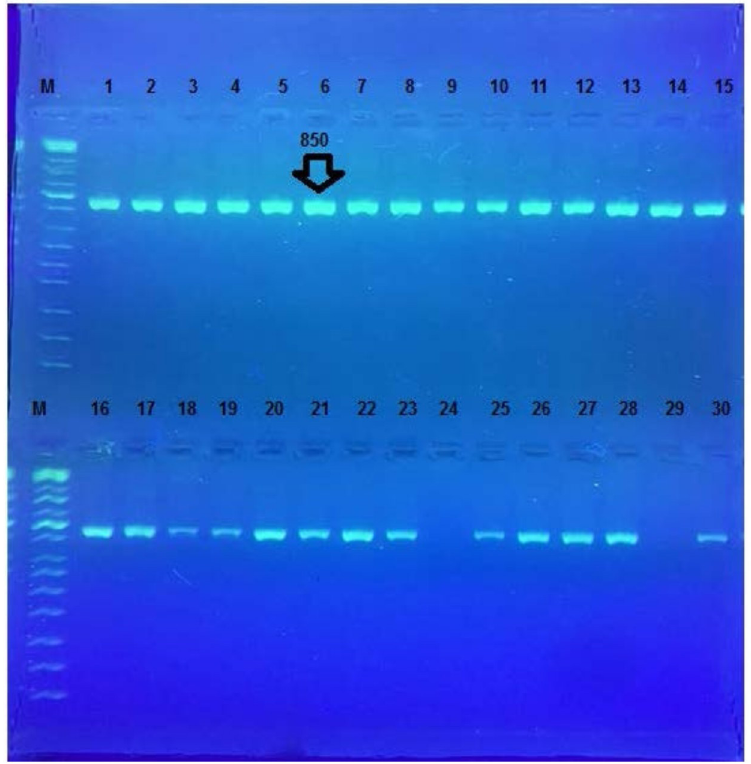
Fig. 3. Agarose gel electrophoresis for16S rRNA gene (850bp). Bands were fractionated by electrophoresis on a 2% agarose gel (2 h., 5V/cm, 1X TBE) and visualized under U.V. light after staining with red stain. Lane: 1 (M: 100bp